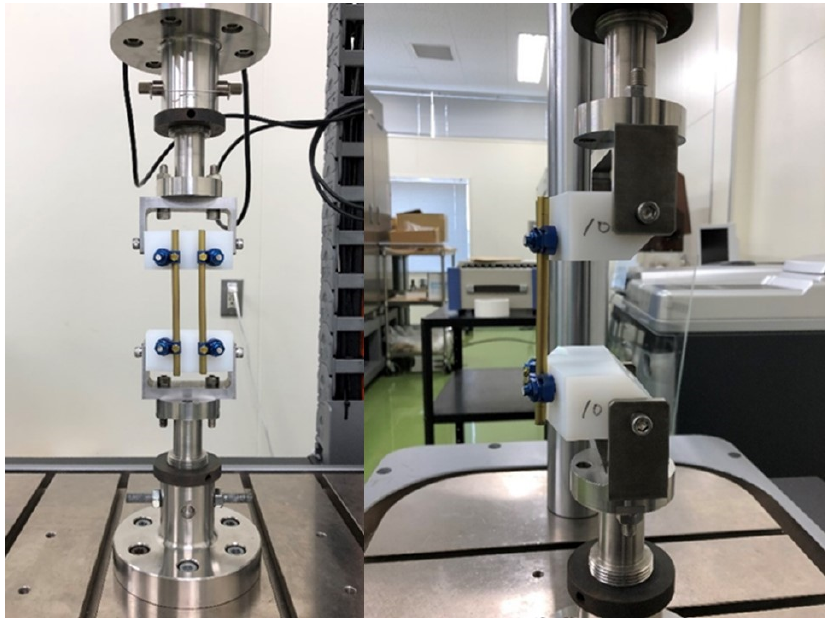
Figure 1. Test specimen installed on the Instron 8521. Four different spinal systems were used in the experiments (Figure